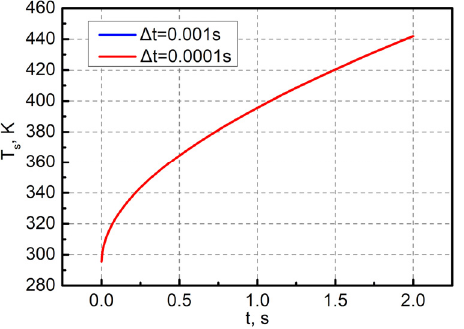
Figure 3. Variation of stagnation temperature with time.